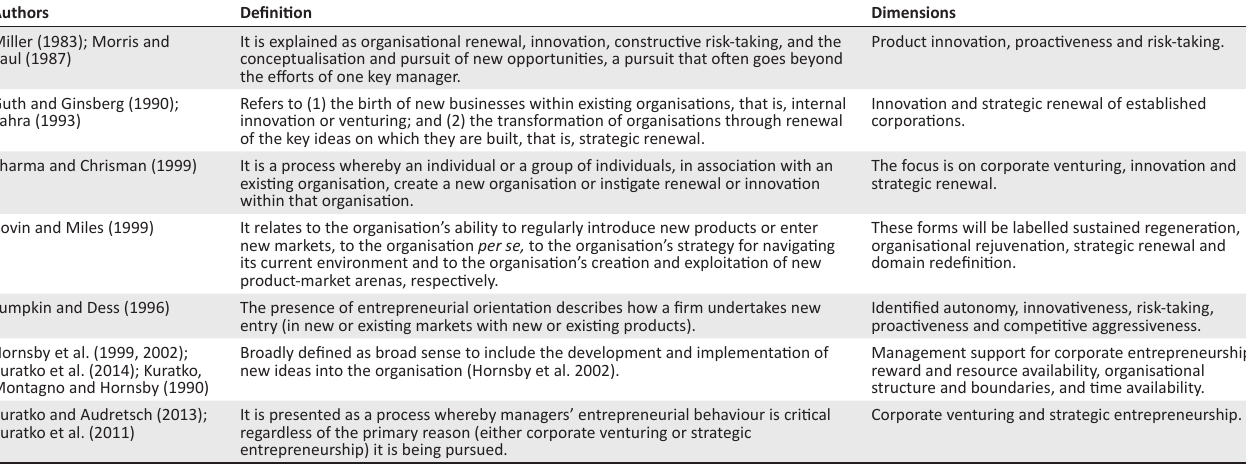
TABLE 1: Definitions and dimensions of corporate